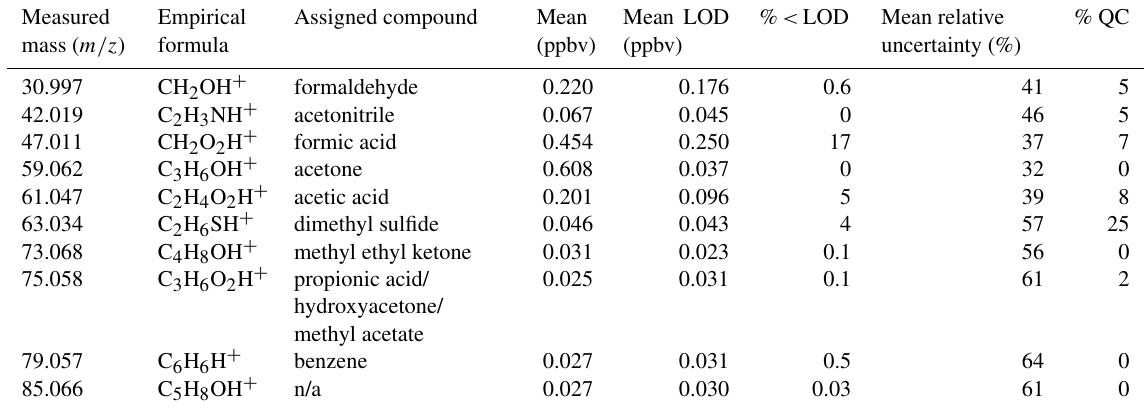
Table 1. Overview of measured protonated masses included in the PMF analysis. Mean refers to the arithmetic average of the mixing ratio for each compound. Mean, mean LOD, and % < LOD were calculated after quality control of data influenced by local pollution. % QC represents the percentage of data removed due to the quality control procedure (Sect. S2 in the